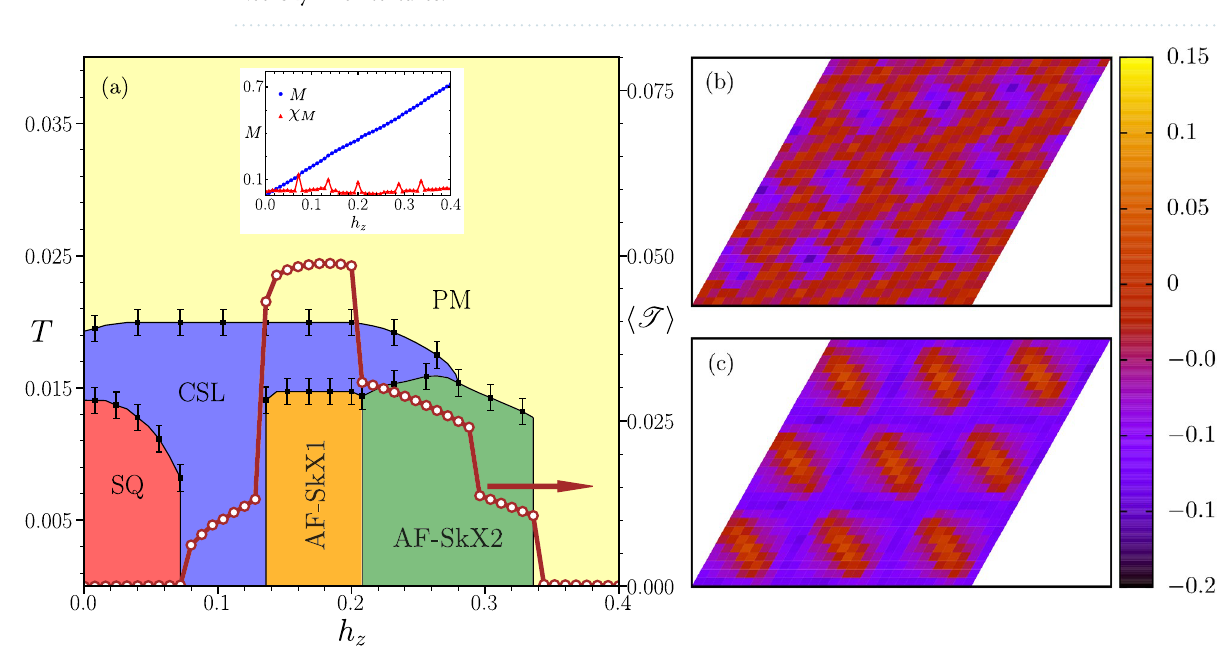
Figure 7. ( a ) The temperature versus magnetic field phase diagram of the Hamilonian Eq. 7. The different phase boundaries are inferred from the order parameter plots shown in Fig. 4. The right axis shows the T variation of skyrmion density with external magnetic field h z . Field dependence of magnetization (blue) (cid:31) (cid:30) and that of its derivative (red) are shown in inset. The real-space maps of the skyrmion density for the two antiferromagnetic skyrmion phases ( b ) AF-SkX1, ( c )